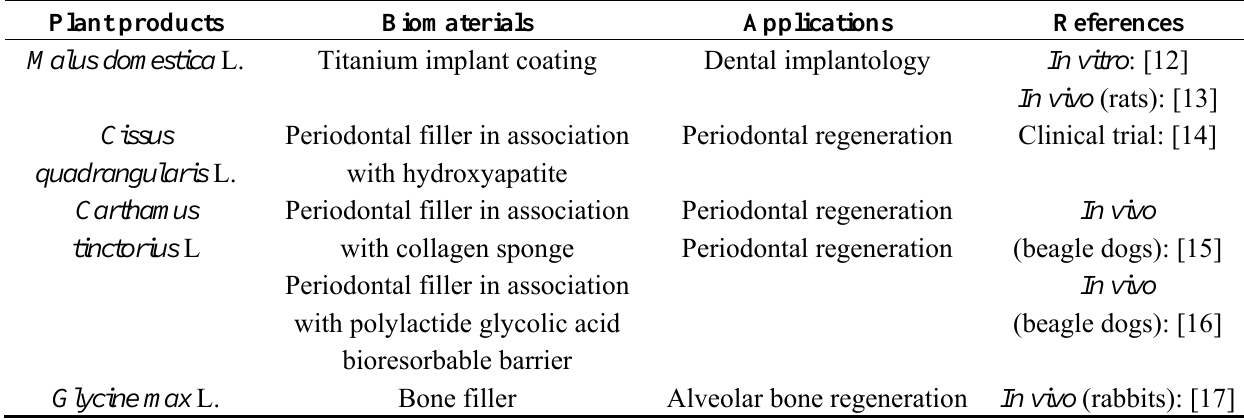
Table 1. Plant products studied for the development and improvement of innovative dental